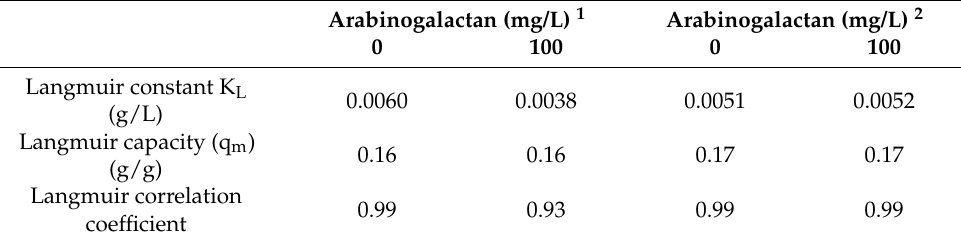
Table 6. Effect of prototypical polysaccharide on protein adsorption. The Langmuir isotherm param- eters in the presence of arabinogalactan are estimated for low protein equilibrium concentrations.